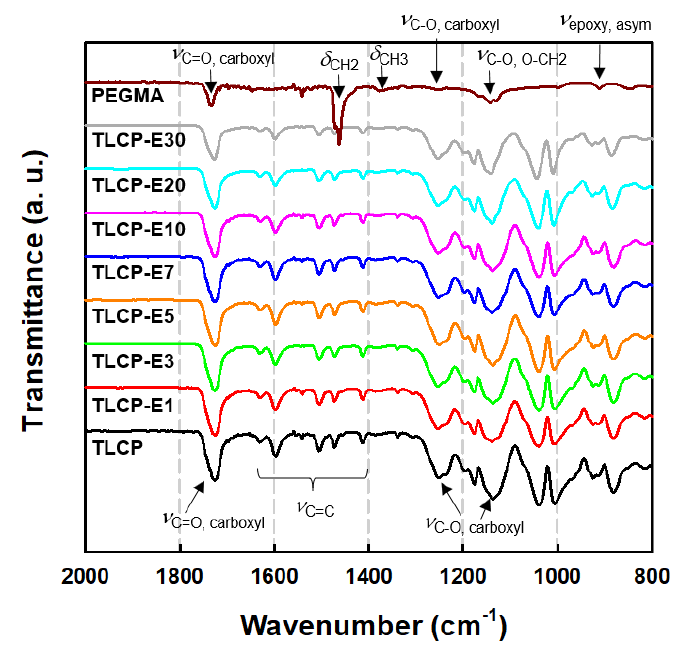
Figure 3. FT-IR spectra of neat TLCP, neat PEGMA, and their blends with different PEGMA contents of 1–30 wt%.